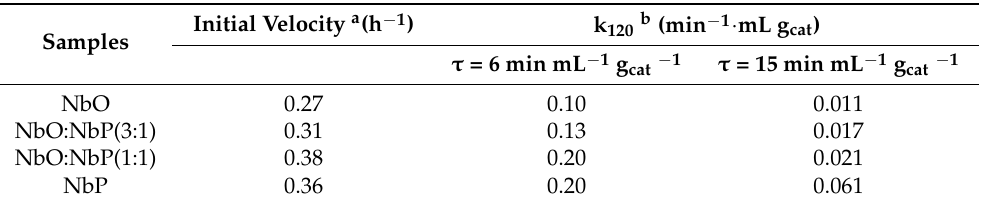
Table 3. Kinetic coefficients for the catalytic dehydration of glucose/fructose in water/ iso- propanol